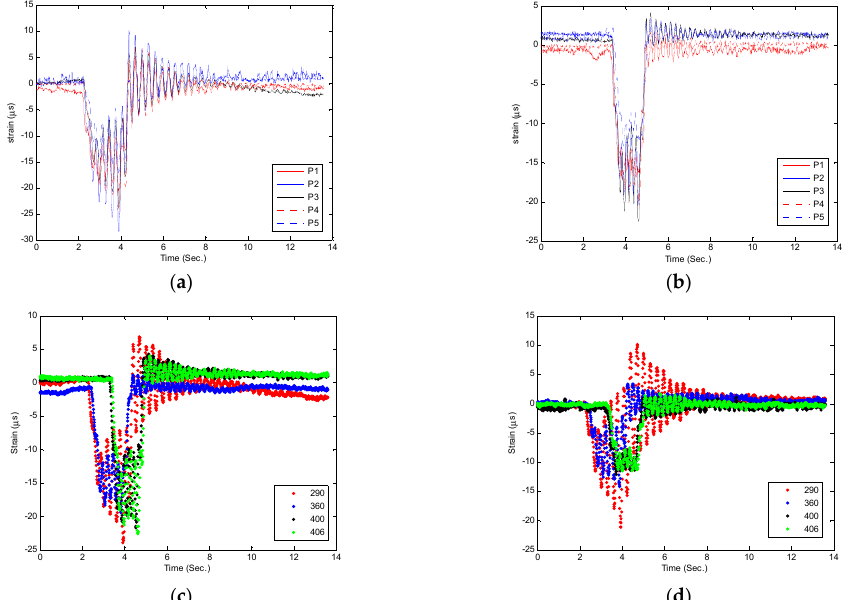
Figure 9. Strain measurements of the main girder induced by high-speed train. ( a ) passing response points for 290 km/h; ( b ) passing response points for 406 km/h; ( c ) passage response mid span points; ( d ) opposite response mid span points.